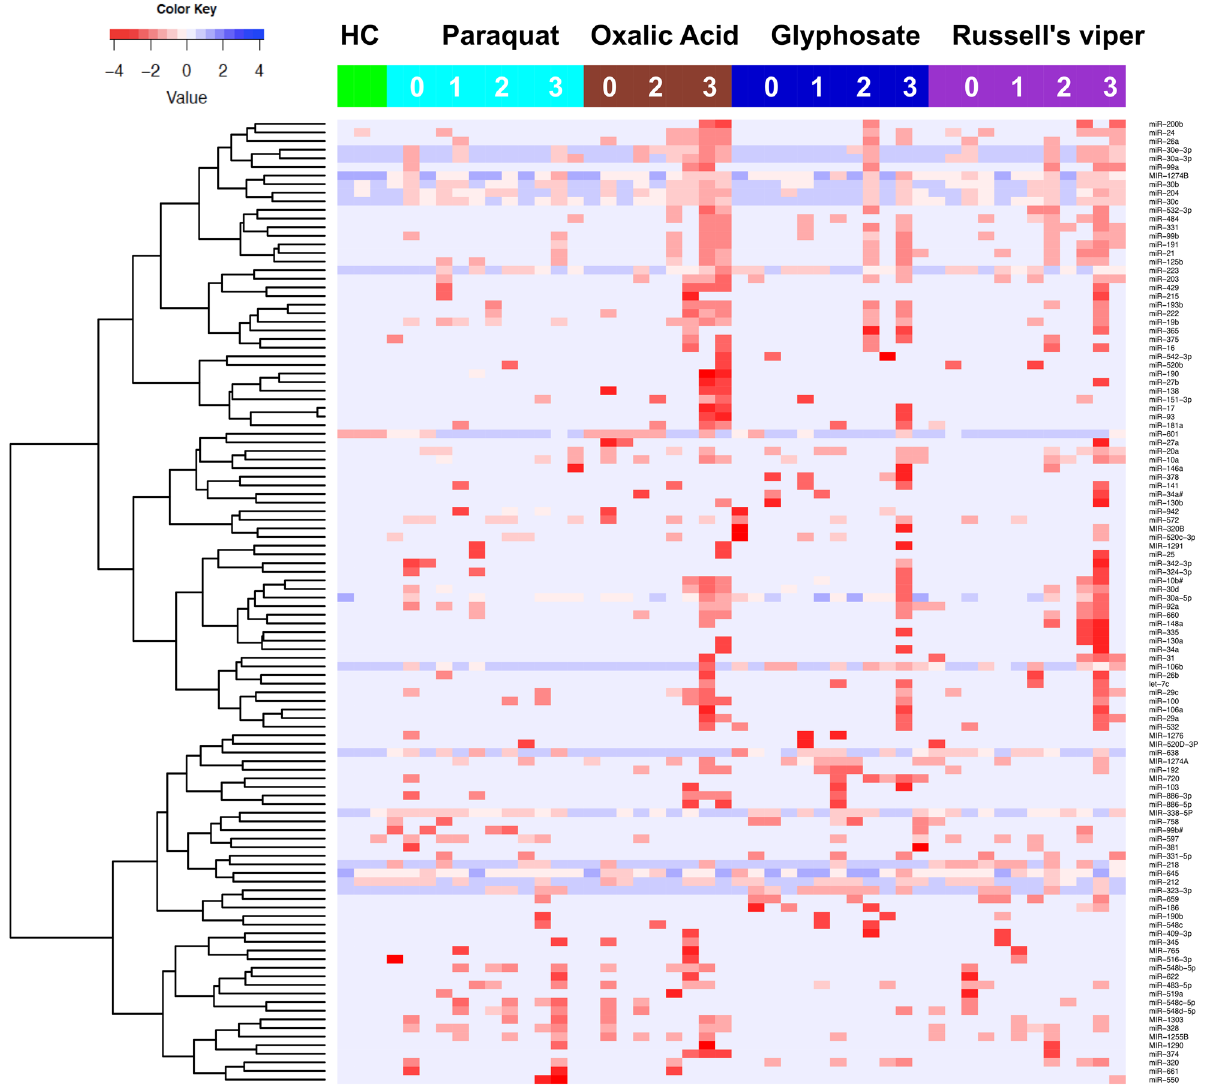
Figure 1. Urinary microRNAs detect AKI after different causes of poisoning. Supervised hierarchical clustering heat map of differentially expressed microRNAs (n=112) distinguished patients with severe AKI from NOAKI and healthy controls. Green, cyan, maroon, dark blue and purple indicates healthy controls, paraquat, Glyphosate, Oxalic acid and Russell’s viper bite respectively. AKI stages are numbered as 0, 1, 2 and 3 for NOAKI, AKIN1, AKIN2 and AKIN3 respectivly. Rows represent microRNAs (normalised Ct) and columns represent the individual samples from healthy controls and